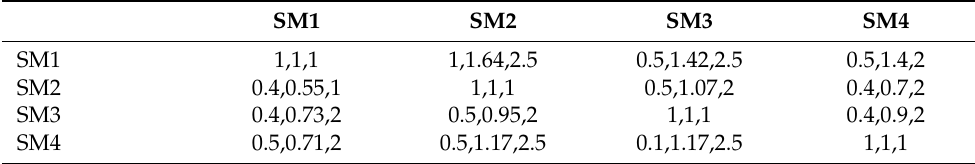
Table 14. FPCM for Quality of Service.